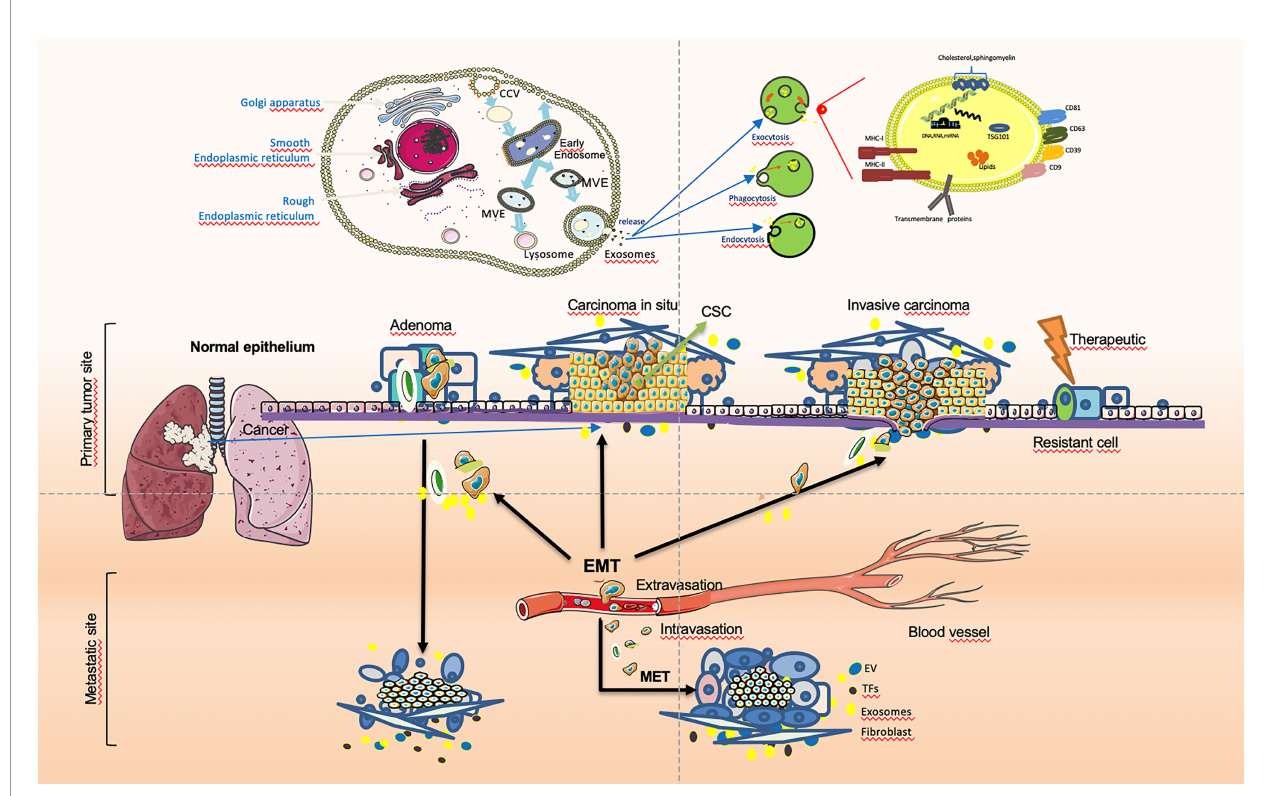
FIGURE 1 | Cancer cells especially cancer stem cells(CSCs)-derived exosome-mediated EMT during cancer progression. In tumor cells, epithelial to mesenchymal transition (EMT) and transcription factors (EMT-TFs), especially tumor-derived exosomes, assign stem cell (SC) characteristics to dedifferentiated tumor cells that are called cancer stem cells (CSCs). The dissemination of tumor cells in the primary tumor and migration after the breakdown of the basement membrane (BM) can be achieved That cells initiates invasion when integrated necessary genetic aberrations and simulated by regarding signals from exosome origins at the tumor. Based on this, providing signals and maintaining the mesenchymal state of metastatic cells may be a positive contribution of EMT.EMT features may promote resistance in the period of anti-tumor therapy, leading to recurrence and poor prognosis. The imbalance between relevant regulatory networks and activated oncogenic approaches at different cancer stages may determine the extent of EMT. In particular CSC in tumor cells-secreted exosomes play an important role as messengers in the dynamic transition between EMT and MET in tumor cells. Cancer cells can activate transfer between EMT and MET while cancer cell